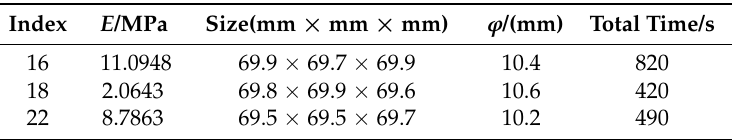
Table 1. Size of samples and experiment parameters.